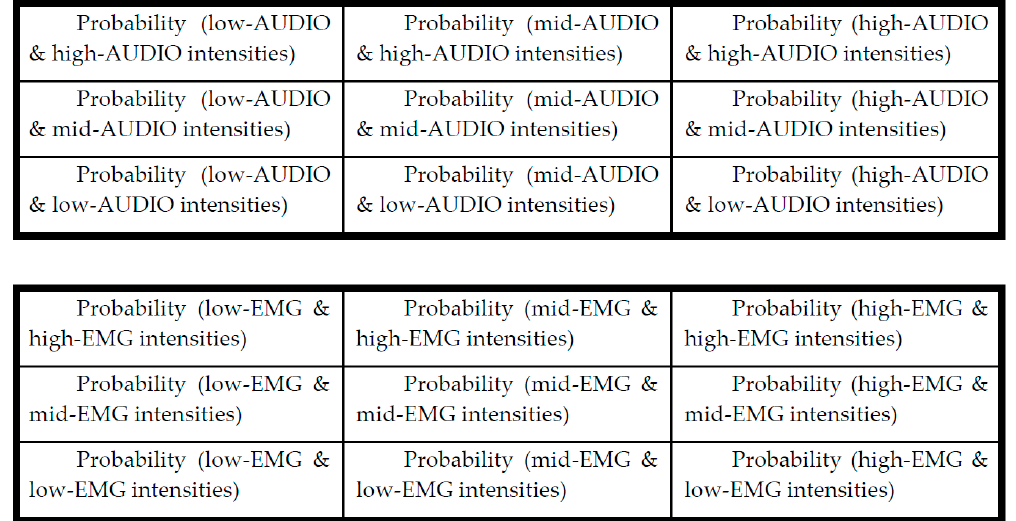
Figure 8. An example formation of the 3 × 3 signature matrices used for the sensor’s audio and EMG signals. The template matrix’s data window is shown in Figure 9 (inspiration; shown in blue and green boxes).